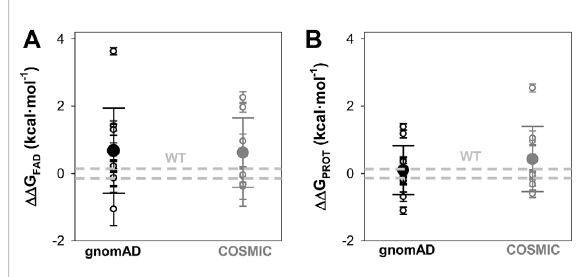
FIGURE 5 Overall effects of gnomAD and COSMIC mutations on the FAD binding af fi nity and the local stability of the FAD binding site (FBS). (A) Changes in apparent FAD binding free energies ( ΔΔ G FAD ) calculatedfromthedifferenceofbindingaf fi nitybetweenWT and a given variant from titrations. Errors are those from linear propagation; (B) Local stability of the TCS (next to the FBS) from proteolysiskinetics. Changesinlocalstability( ΔΔ G PROT )calculated from the difference of the second-order rate constant between WT and a given variant. Errors are those from linear propagation; Forreference,thevaluescorrespondingtoWTNQO1areshownin light grey. Variants are grouped in the gnomAD and COSMIC